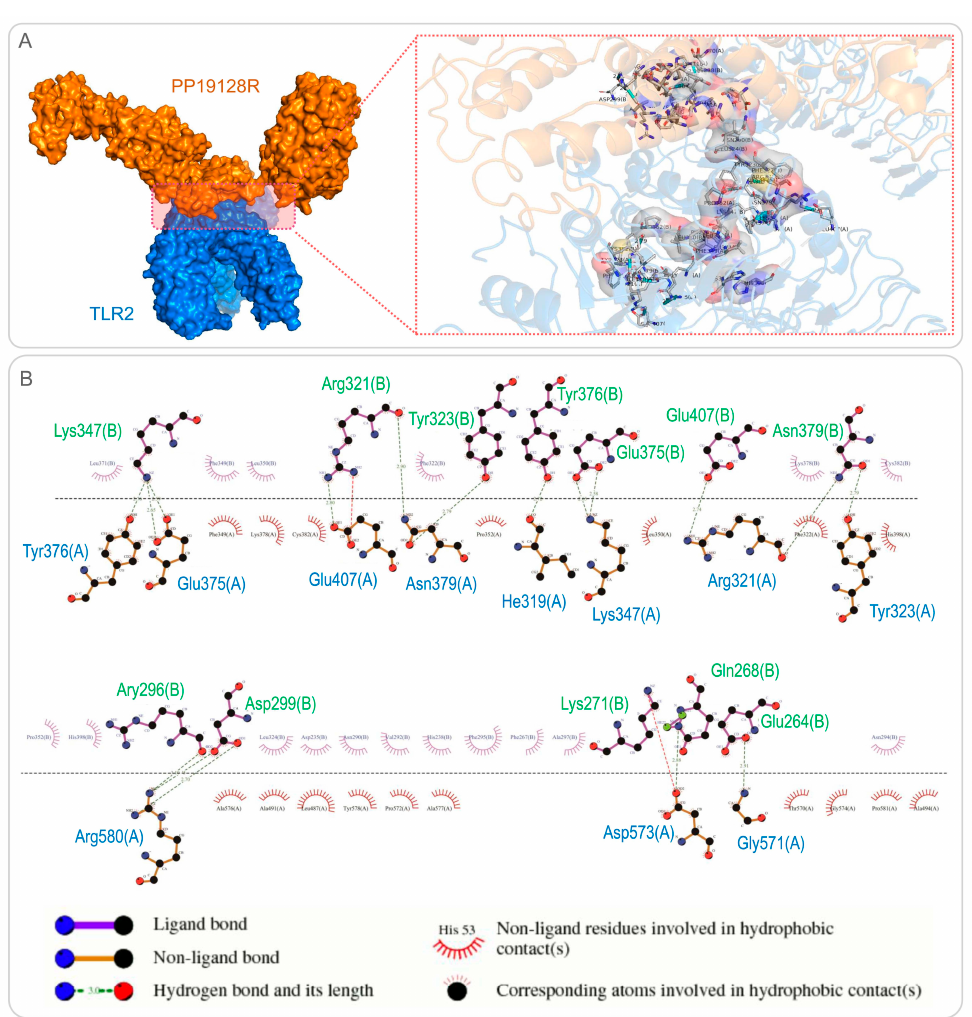
Figure 3. Molecular docking and binding site analysis for the PP19128R vaccine and TLR2. ( A ) Molecular docking between the PP19128R vaccine (in yellow) and TLR2 (in blue) was predicted by using the Cluspro server. A cartoon illustration of molecular docking is shown in the left panel. A 3D illustration of the interactions between bonds at the molecular docking site is shown in the right panel. ( B ) A 2D illustration of the binding sites between the PP19128R vaccine and TLR2 predicted by LigPlot+ v.2.2 (https://www.ebi.ac.uk/thornton-srv/software/LigPlus/ (accessed on 18 February 2023).